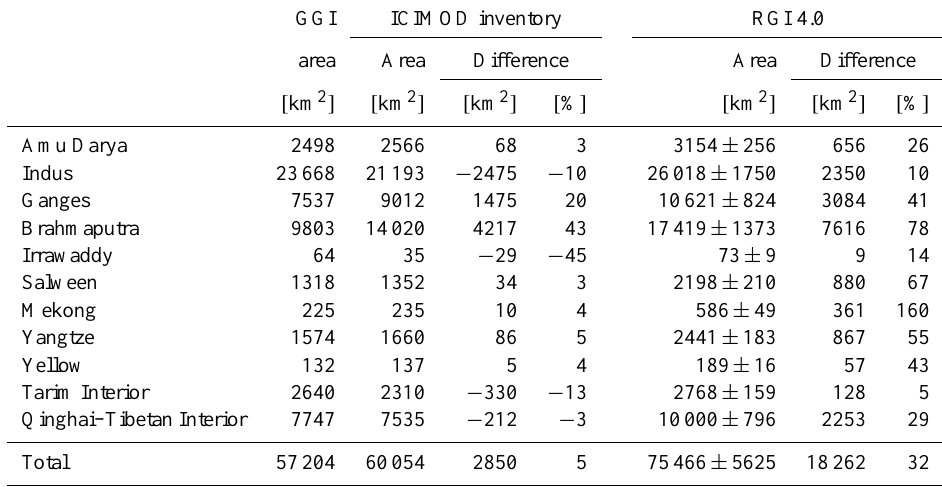
Table 2. Summary of glaciers in the GGI, ICIMOD inventory, and the RGI 4.0. The uncertainty in the RGI ver. 4.0 was calculated using the error estimation equation (Eq. 1) in Pfeffer et al.